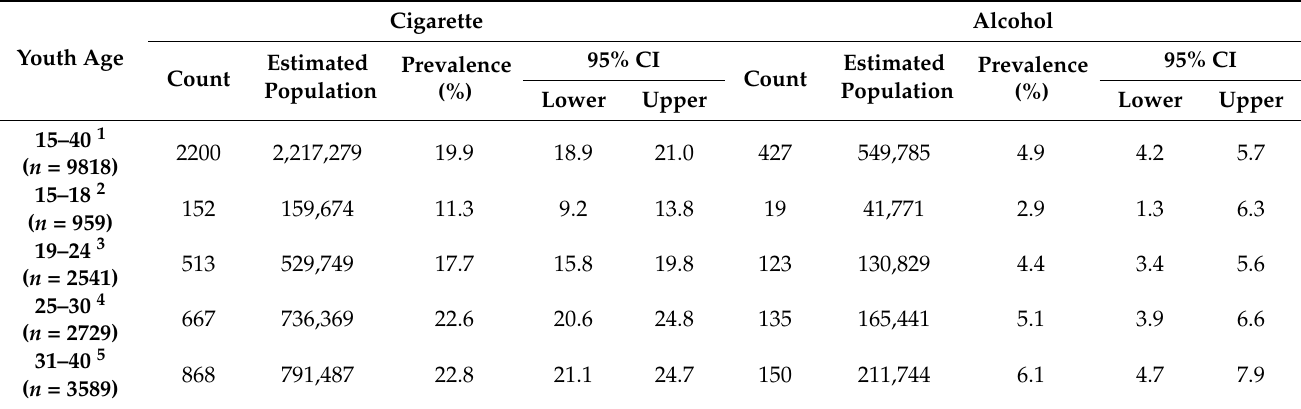
Table 3. Prevalence of lifetime substance abuse by type according to age categories.